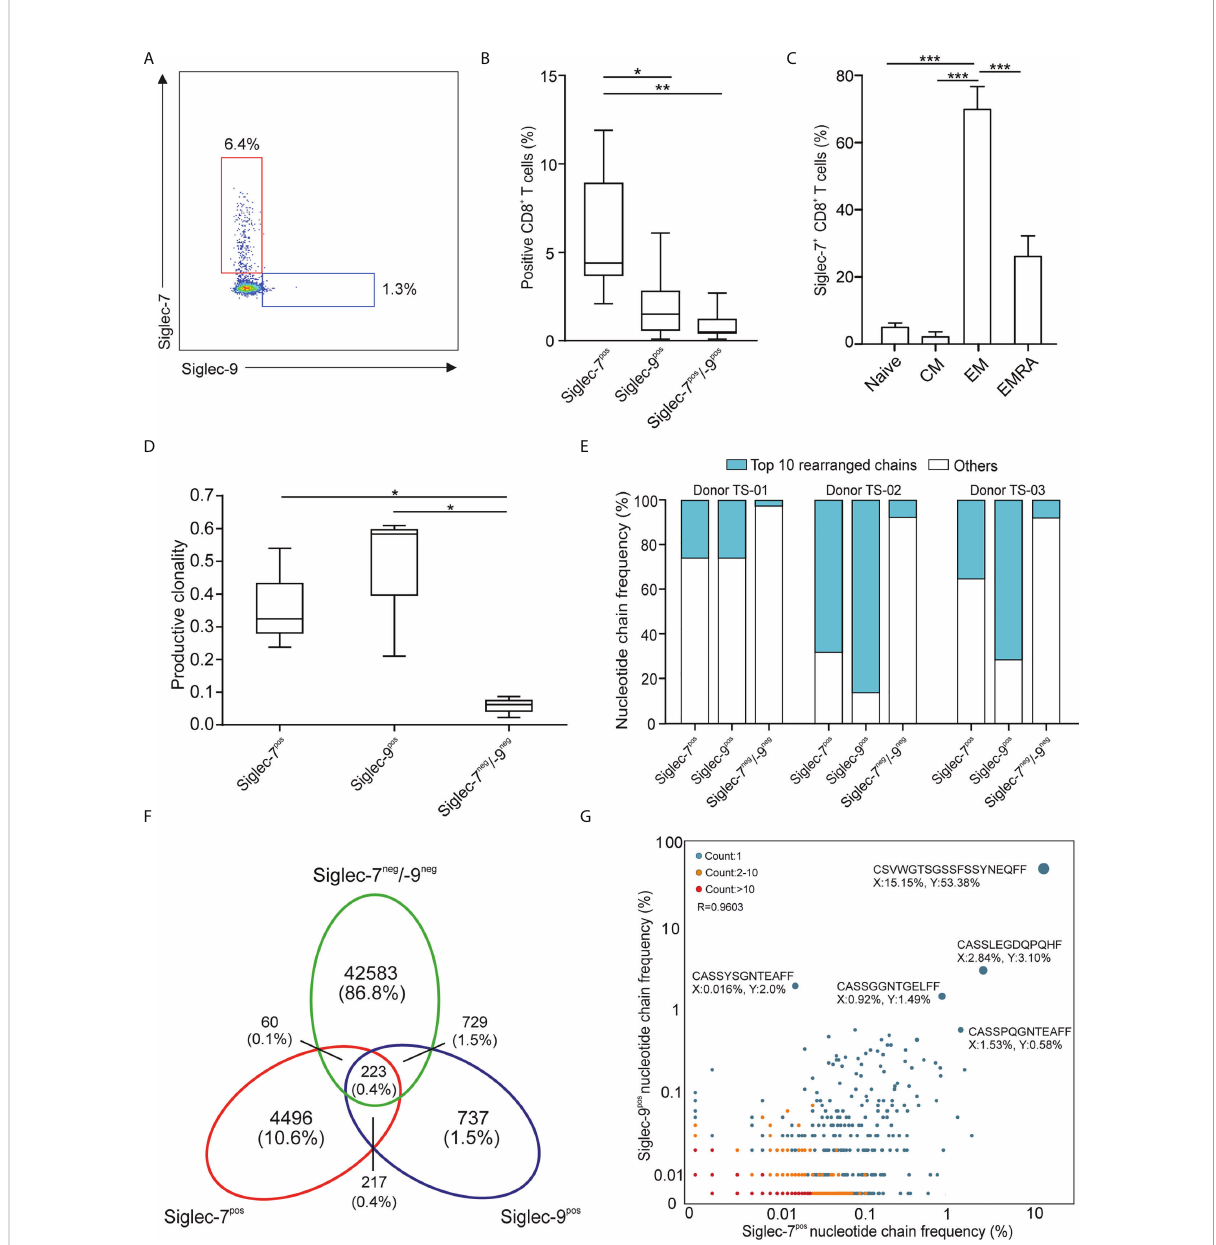
FIGURE 1 Siglec-7 de fi nes a unique subset of effector memory CD8 + T cells in healthy donor peripheral blood. (A, B) Representative fl ow cytometry plot (A) and quantitative analysis (n=23) (B) for comparison of Siglec-7 and Siglec-9 surface expression on healthy donor peripheral blood CD8 + T cells. (C) Composition of Siglec-7 + CD8 + T cell subsets, including naive, central memory (CM), effector memory (EM), and CD45RA + effector memory (EMRA) cells (n=8). (D – G) TCRv b chain analysis of peripheral blood CD8 + T cell subsets. Productive clonality (D) and clonotype frequency distribution (E) for three individual donors. Venn diagram (F) and scatter plot (G) representation displaying clonotypes distribution among CD8 + T cell subsets for donor TS-02. Statistical analysis was performed by one-way ANOVA followed by (B, C) Bonferroni or (D) Dunn posttest. *P < 0.05; **P < 0.01; ***P < 0.001. Error bars,